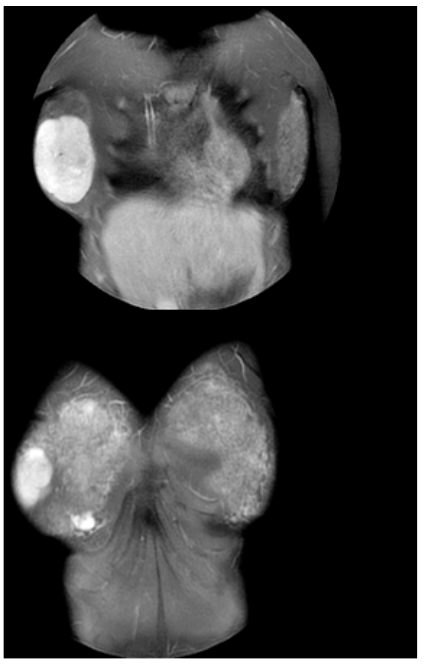
Figure 2. MRI imaging of a 7.4 cm × 6 cm × 8.1 cm mass with clear margins and characteristics compatible with giant fibroadenoma.